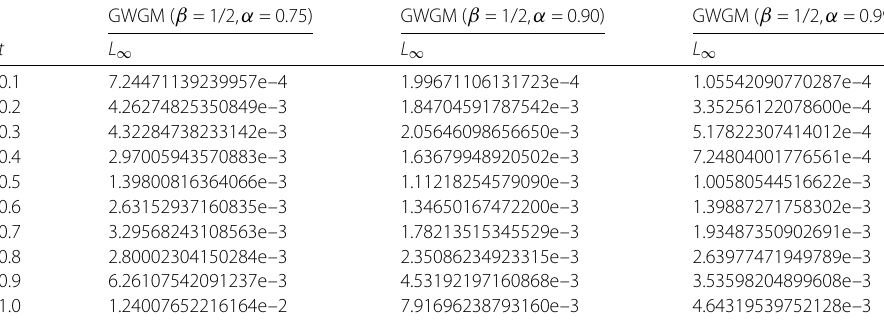
Table 8 Comparison of L ∞ errors of Example 2, for various values of t GWGM ( β = 1/2, α = 0.75) GWGM ( β = 1/2, α = 0.90) GWGM ( β = 1/2, α = 0.99) L